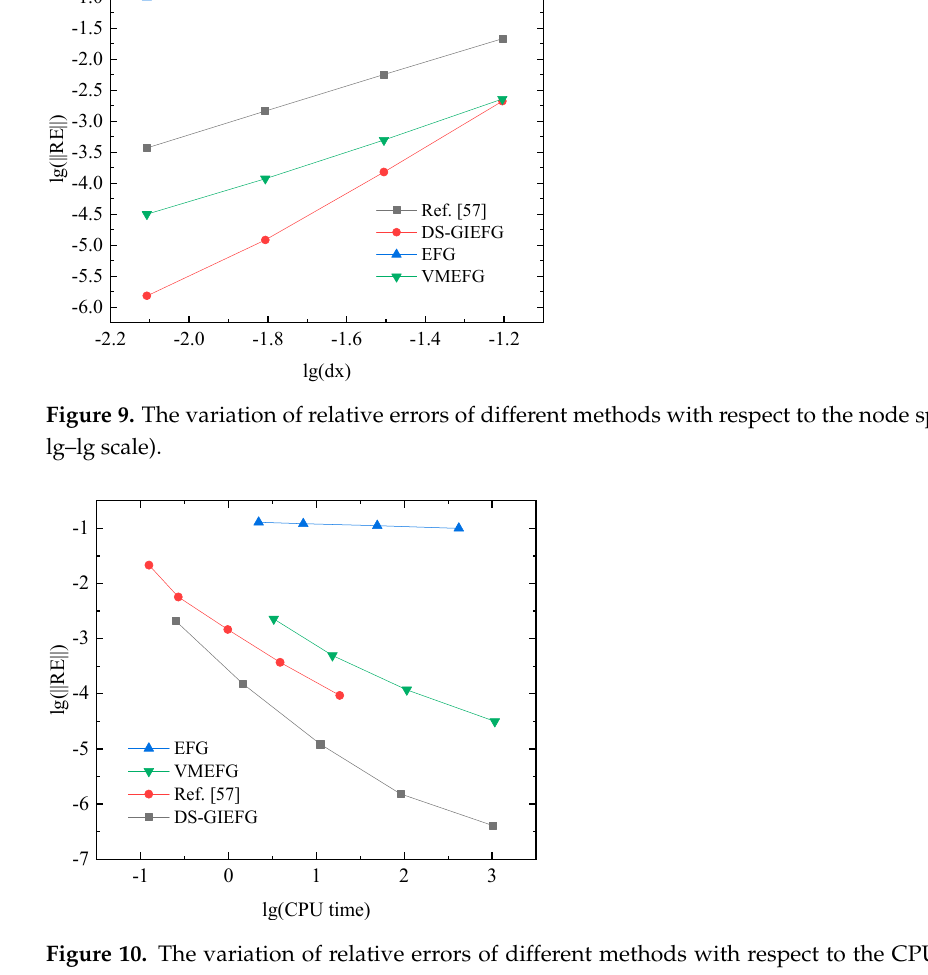
Figure 10. The variation of relative errors of different methods with respect to the CPU time (in lg–lg scale).